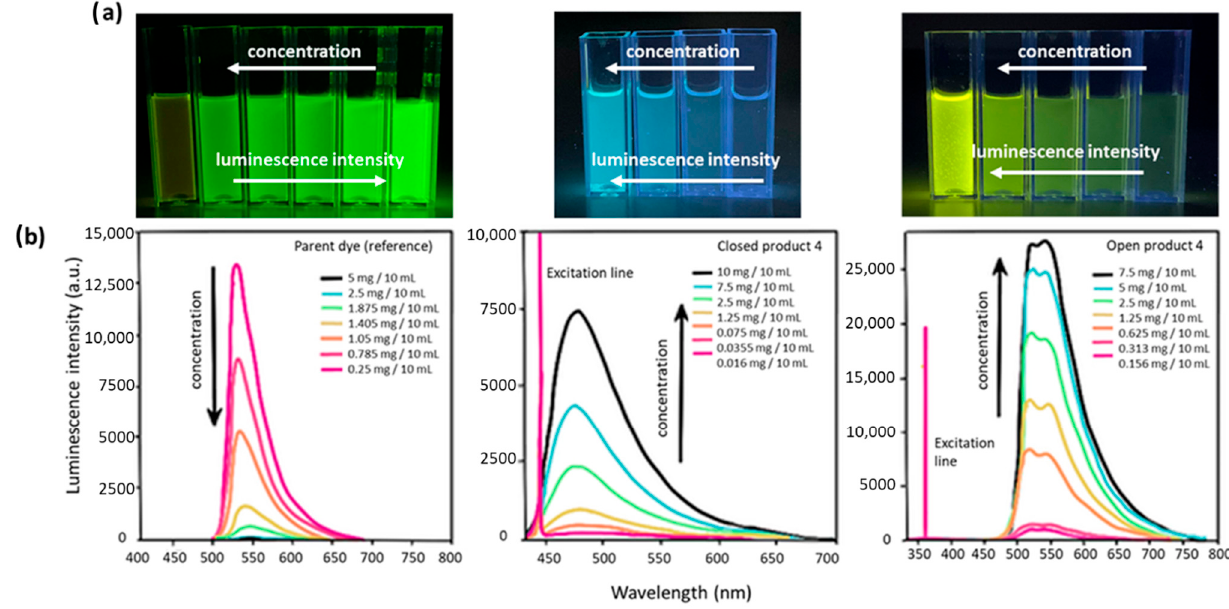
Figure 5. ( a ) Photographs of obtained solutions with different concentrations under excitation with UV lamp ( λ ex = 360 nm). From left: fluorescein, compound 4A , compound 4B ; ( b ) Emission spectra of synthesized closed and open compounds 4A and 4B in comparison to fluorescein. Spectra for open product and reference fluorescein were registered in 0.1 M NaOH, while closed form in ACN. For reference and open product were recorded with λ ex = 360 nm and λ ex = 455 nm for closed one.